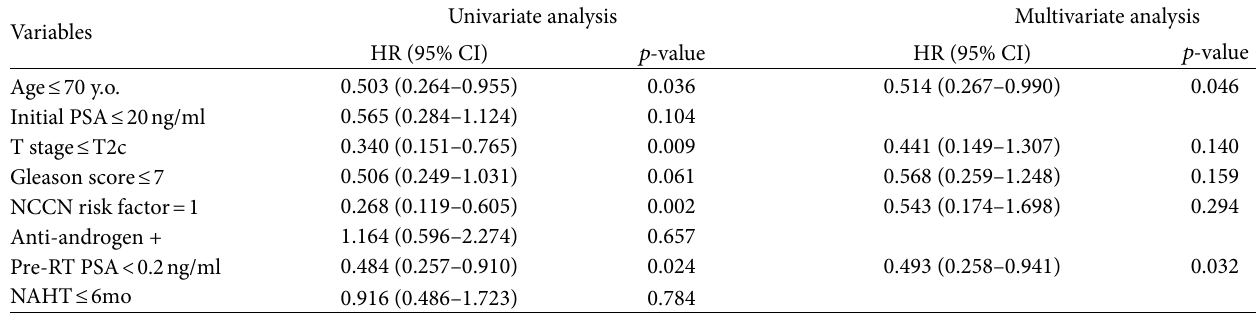
Table 3: Multivariate analysis of factors affecting overall